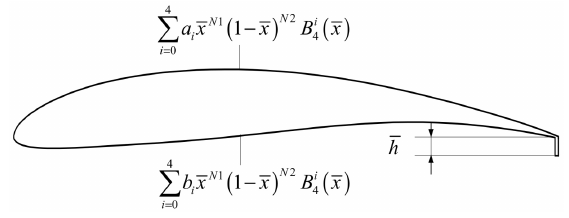
Figure 9. Parametric method for a Gurney flap